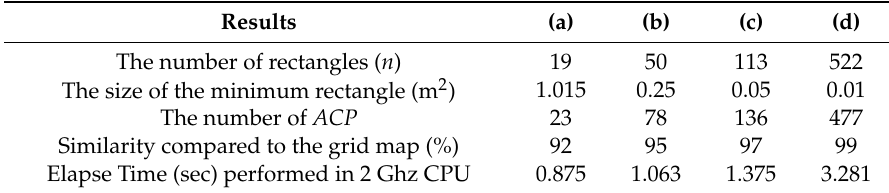
Figure 9. The memory efficiency experiment results of the Rmap in a simulated Figure 8a environment. The n is the number of rectangles used for the map representation. ( a ) n = 19, ( b ) n = 50, ( c ) n = 133, ( d ) n = 522. Table 1. The numerical results of the memory efficiency experiment.